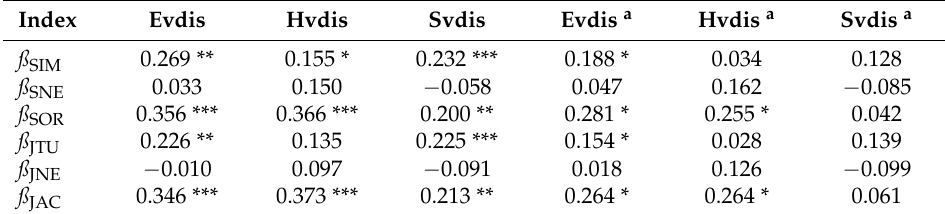
Table 5. Results of Mantel and partial Mantel test for the correlation between ß -diversity and dissimilarity matrices based on Euclidean distances for spatial (Svdis), hydrological (Hvdis), and environmental variables (Evdis) in upstream Lijiang River. For other abbreviations: see Table